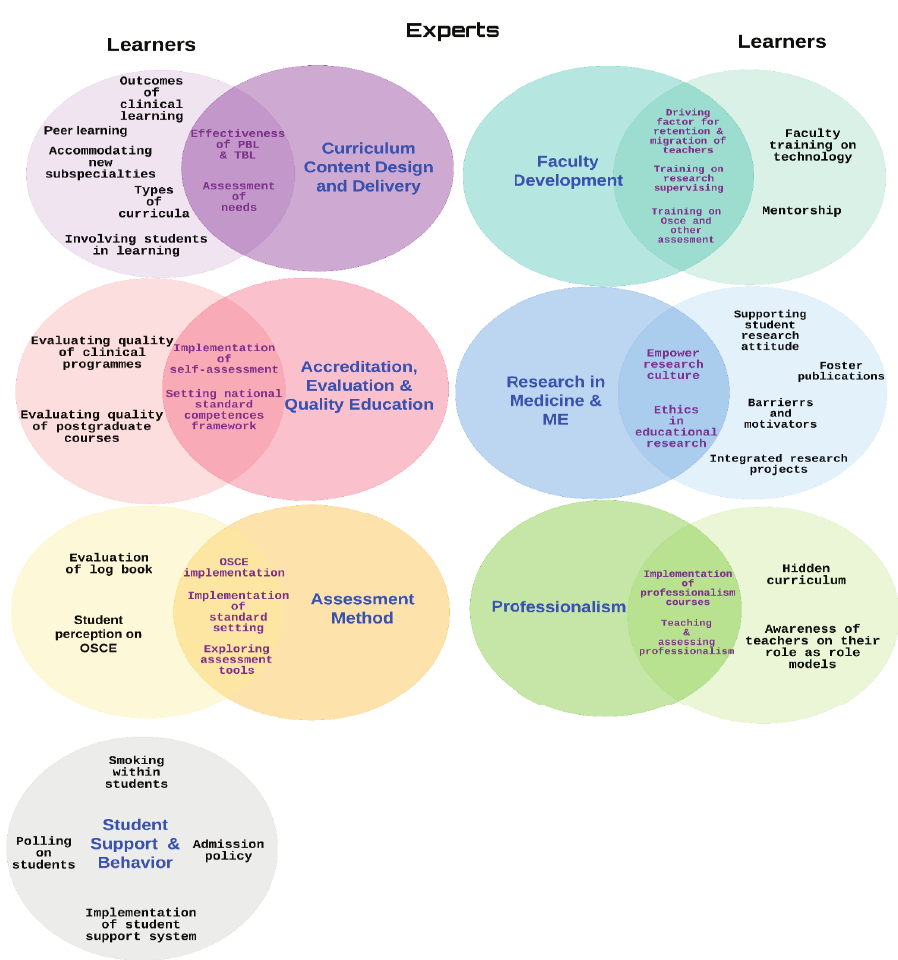
Figure 4 : Framework Analysis; Fitting the codes evolved from the learners’ opinions into the framework generated from experts’ opinions. New subthemes and a single principal theme